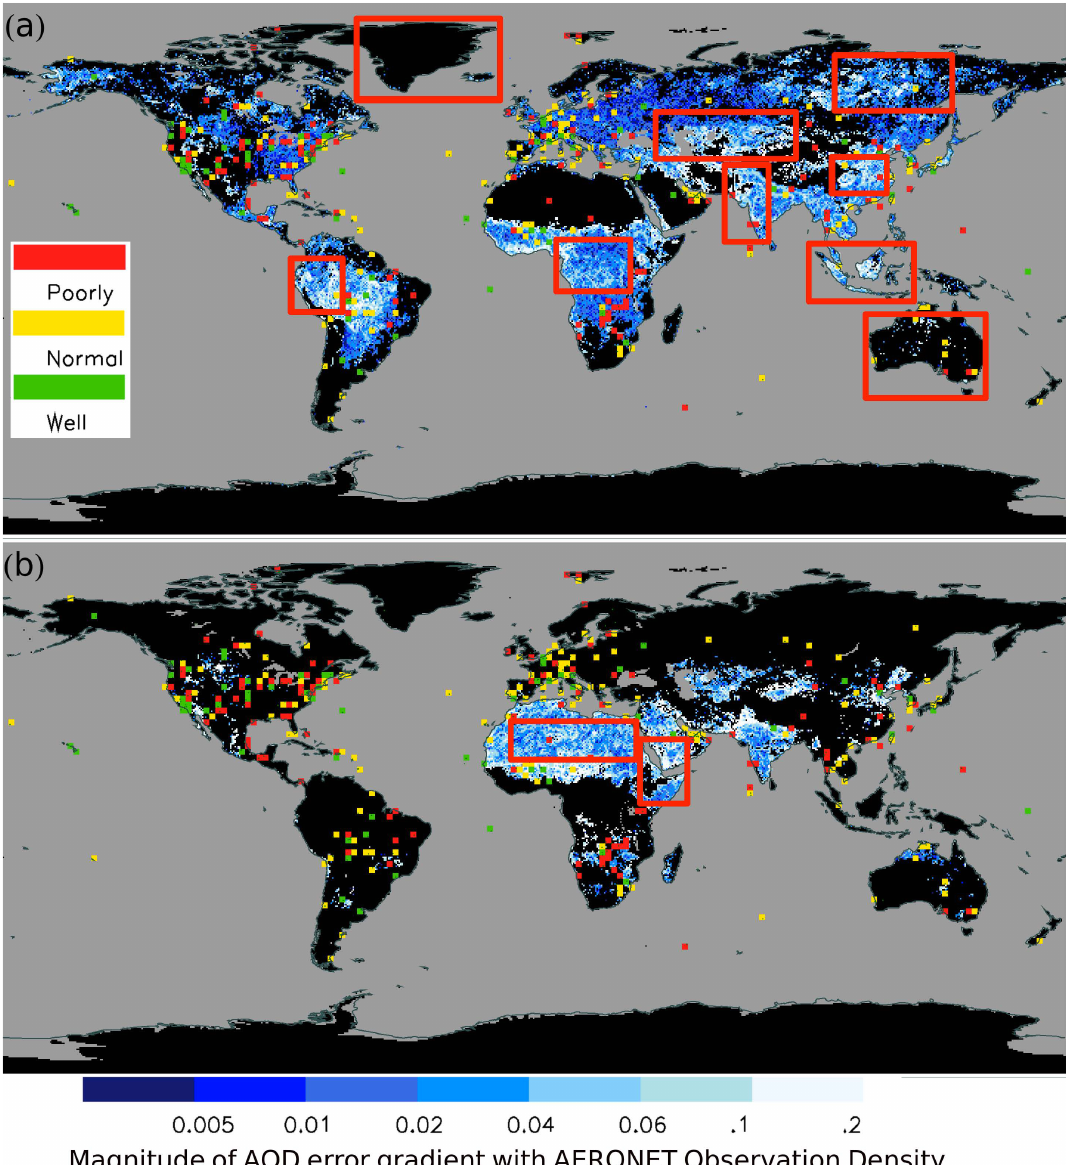
Fig. 5. The spatial distribution of the gradient of AOD differences ( 1 AOD) between the MODIS and MISR aerosol products. The 1 AOD was computed by subtracting MODIS DT/MODIS DB (0.55µm) AOD from MISR AOD (0.558µm). Only land regions that have reported AOD larger than 0.1 from both products were used for computing the gradient. Over-plotted on top of the gradient map is the AERONET density map. For AERONET observation density, for every one by one degree grid, one AERONET site that has observation for a month during the 1993–2009 periods is counted as one. Regions that have index of 0–12, 12–60, and above 60 are considered poorly, normal, well observed area for red, yellow and green, respectively. Oceans are plotted in grey. (a) for MODIS DT and (b) for MODIS